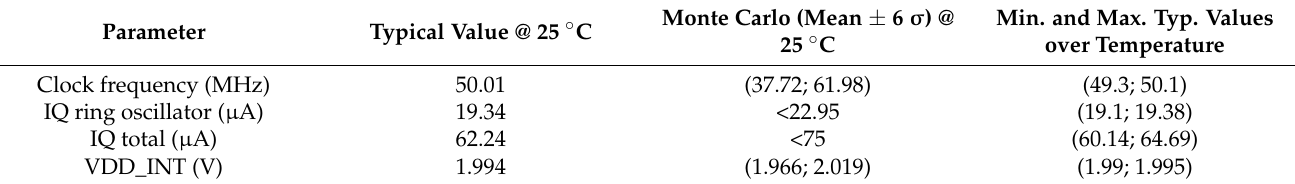
Table 3. Results summary for 2 V supply voltage.